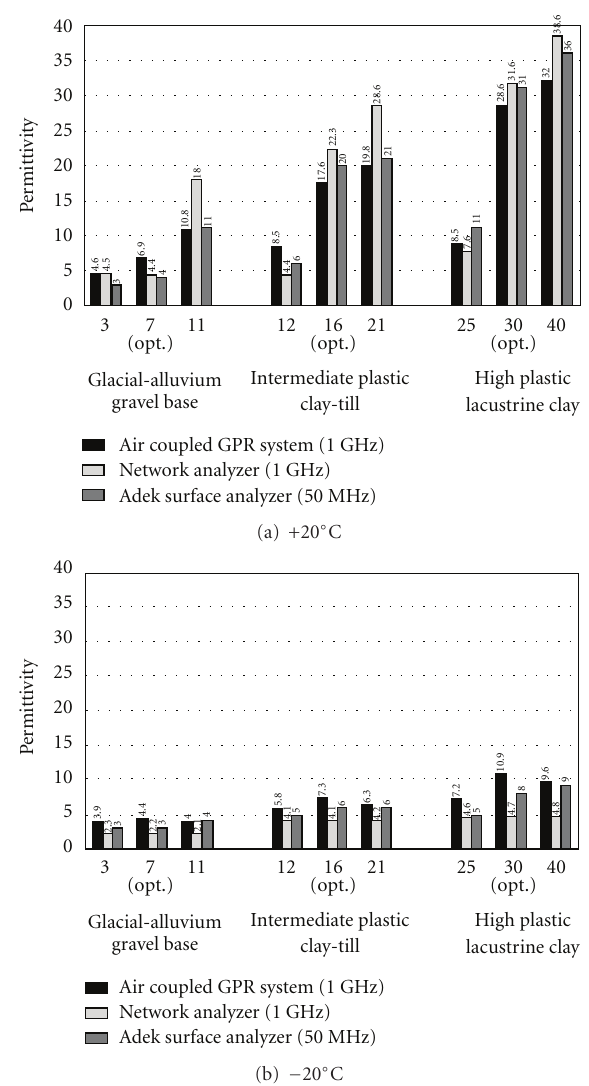
Figure 9: Summary of permittivity